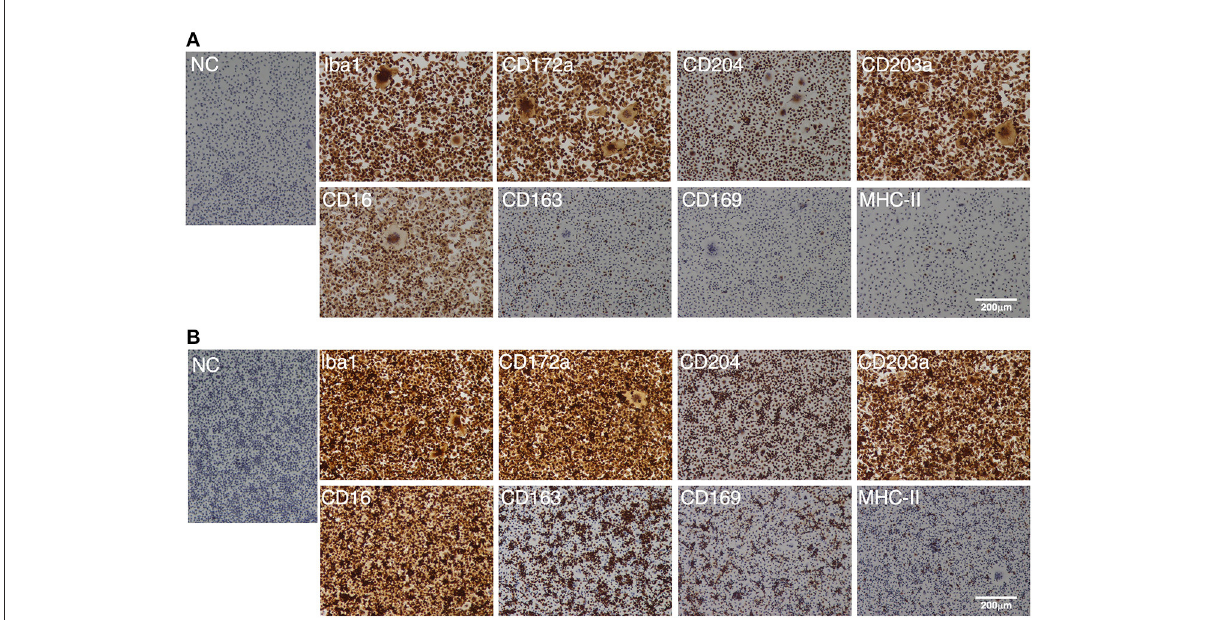
FIGURE3 Immunocytochemical characterization of IPIM. The IPIM were seeded in 8-well-chamber slides and cultured for 1 day (A) or 3 days (B) . Then, the cells were fixed using 4% paraformaldehyde phosphate buffer solution, and immunostained with specific antibodies against cell markers of macrophages (Iba1, CD172a, CD204, CD203a, and CD16) or specific subpopulations of macrophages (CD163, CD169, and MHC-II) ( brown ). No specific staining was observed if the cells were treated without primary antibodies [NC: negative control in (A,B) ]. All nuclei were counterstained with hematoxylin ( blue ). Images are representative of three independent